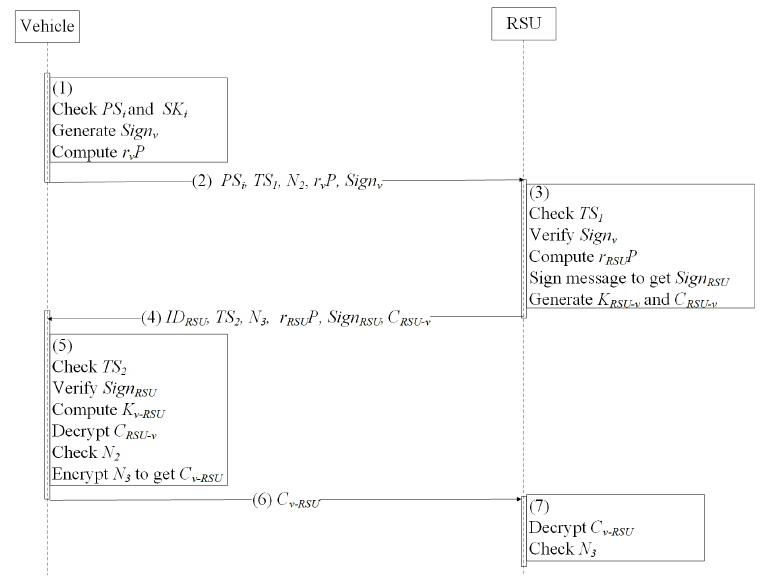
Figure 3. Vehicle-to-infrastructure (V2I) authentication protocol.